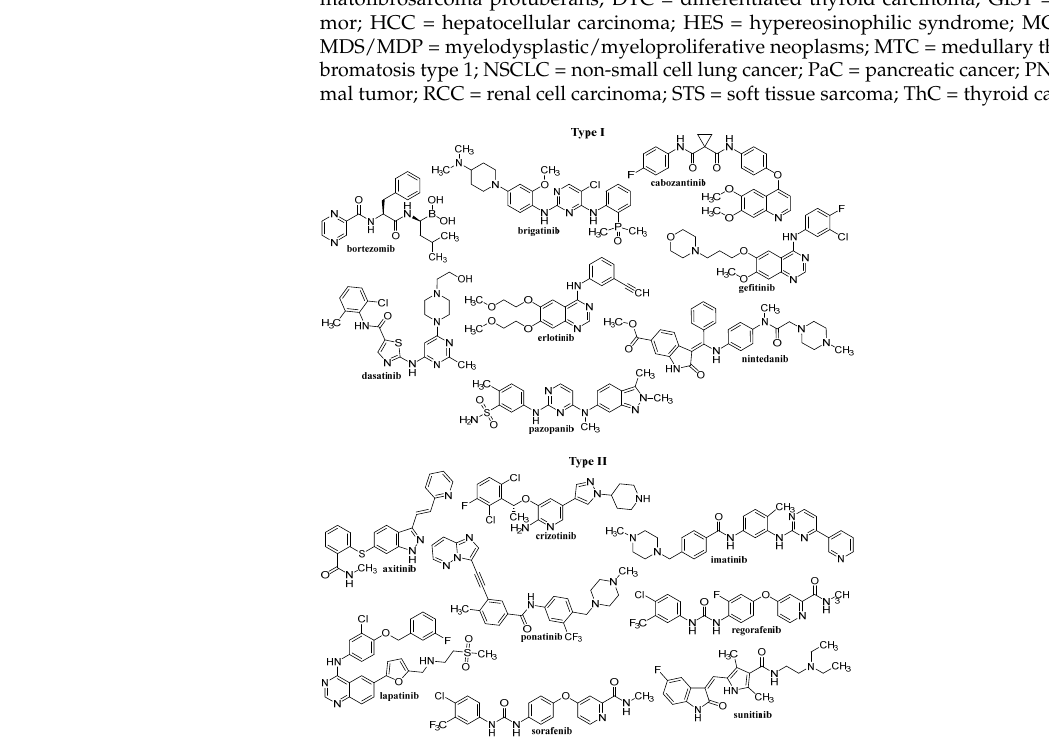
Figure 4. The structures of discussed TKIs of types I and II according to their mechanisms of action.